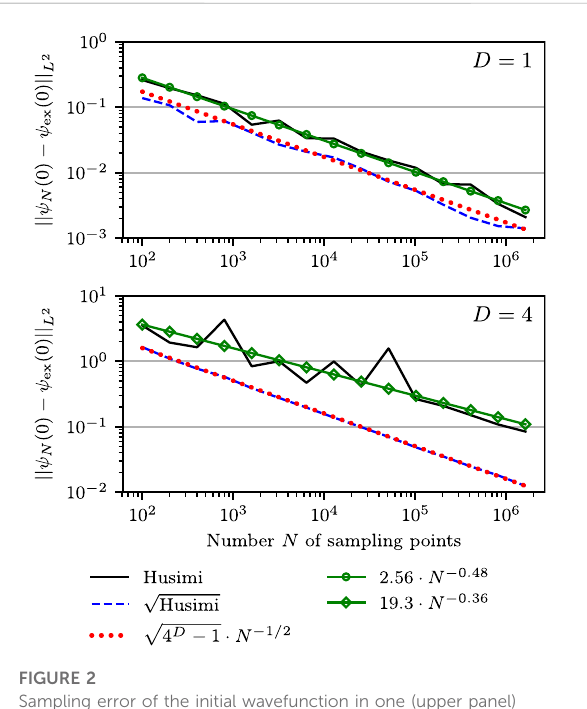
FIGURE 2 Sampling error of the initial wavefunction in one (upper panel) and four (lower panel) dimensions as a function of the number N of Monte Carlo points. The plot displays the error for sampling from the Husimi density (Case H) and its approximated convergence (marked lines) as well as the error for sampling from thesquare root of the Husimi density (Case sqrt-H) and its analytical error estimation (dotted